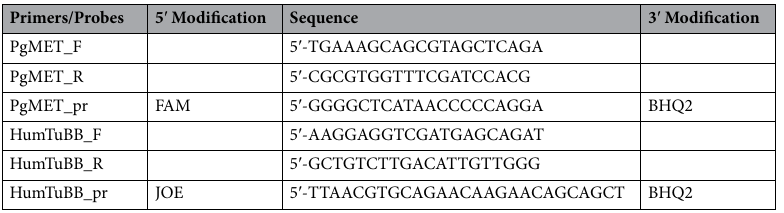
Table 3. Primers and probes for parasite density